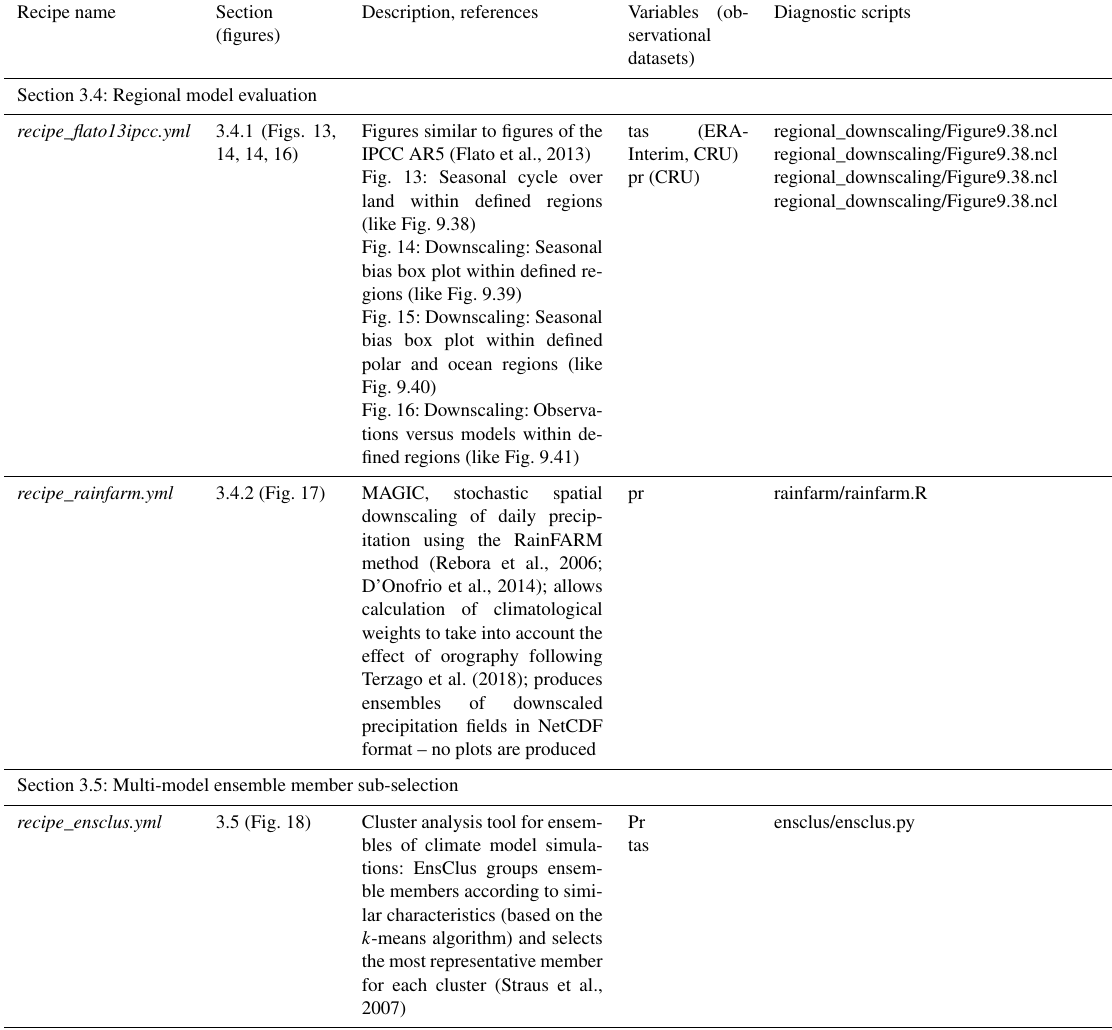
regional_downscaling/Figure9.38.ncl tas (ERA- Interim, CRU) regional_downscaling/Figure9.38.ncl pr (CRU)